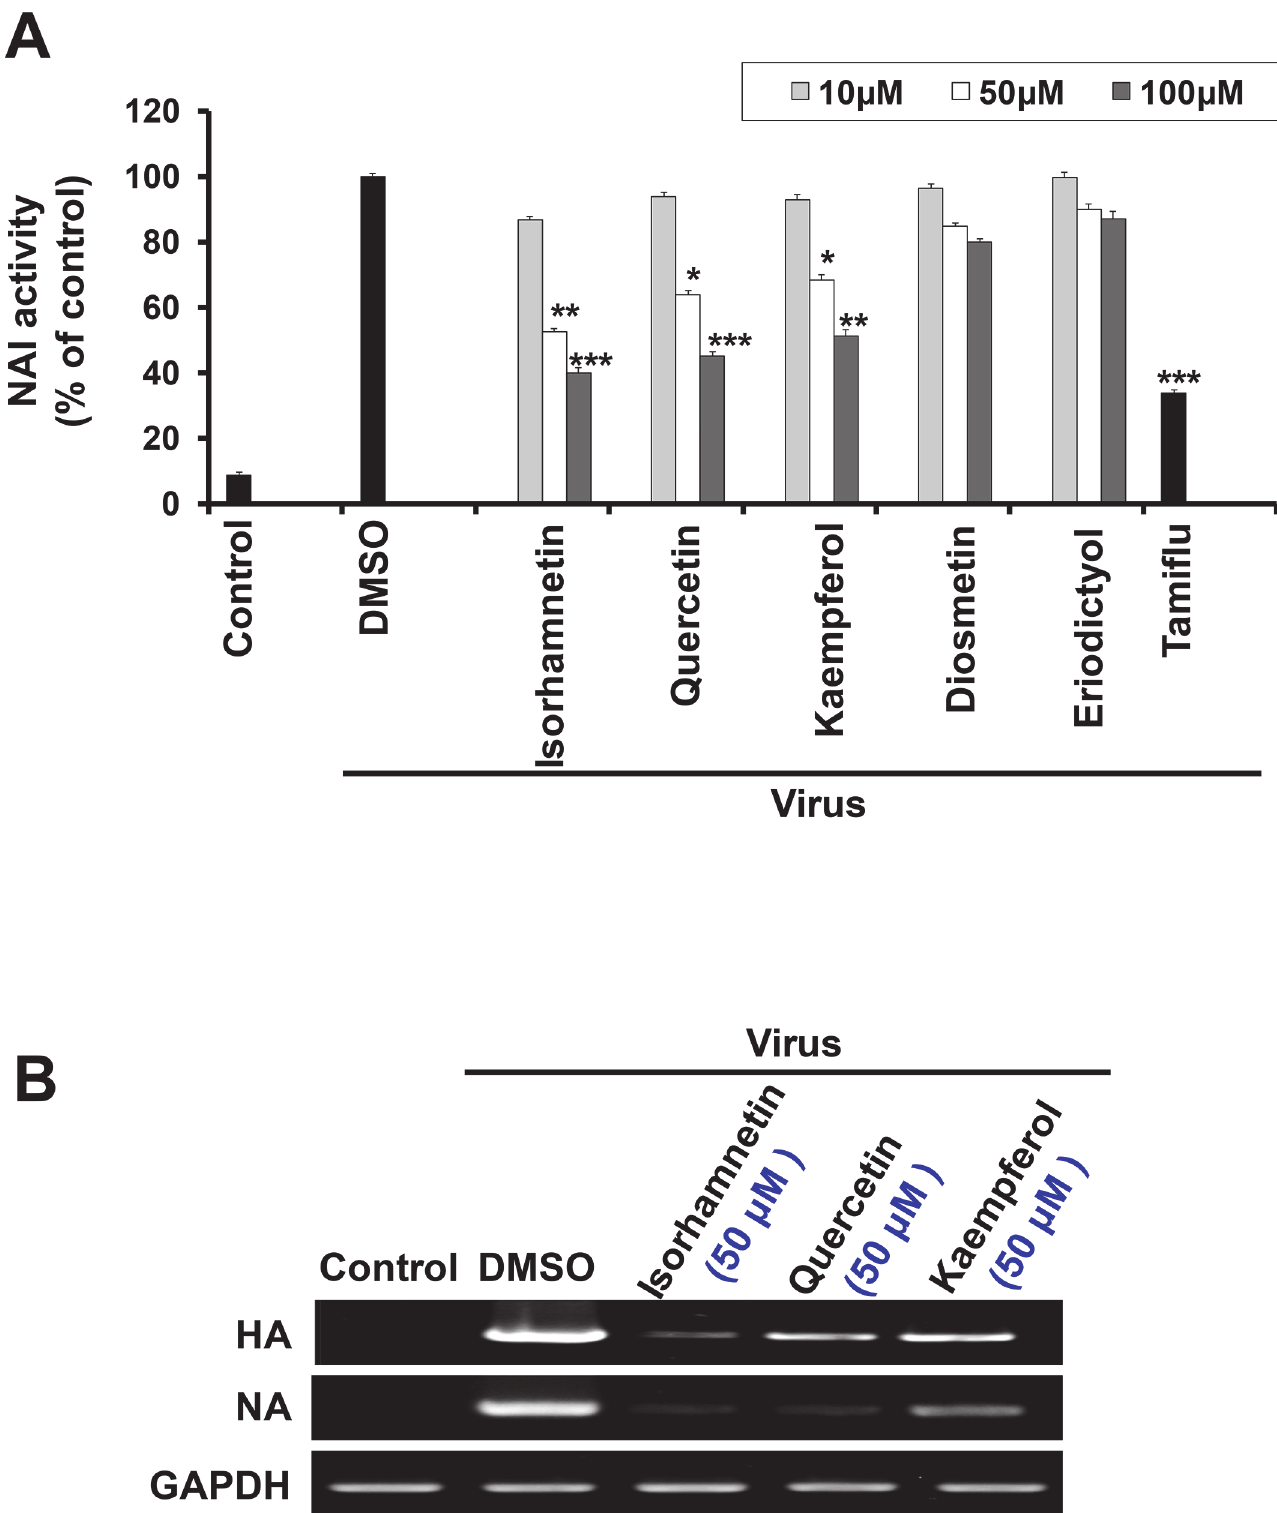
Fig 4. Measurement of antiviral activity of isorhamnetin by NA assay and RT-PCR. (A) NAI assay was assessed by mixing of 50 μ L of the flavonoids at the indicated concentrations with 50 μ L of the virus, and then adding 100 μ L of the substrate solution (4-MU-NANA; (2 0 -(4-methylumbelliferyl)- α - D - N